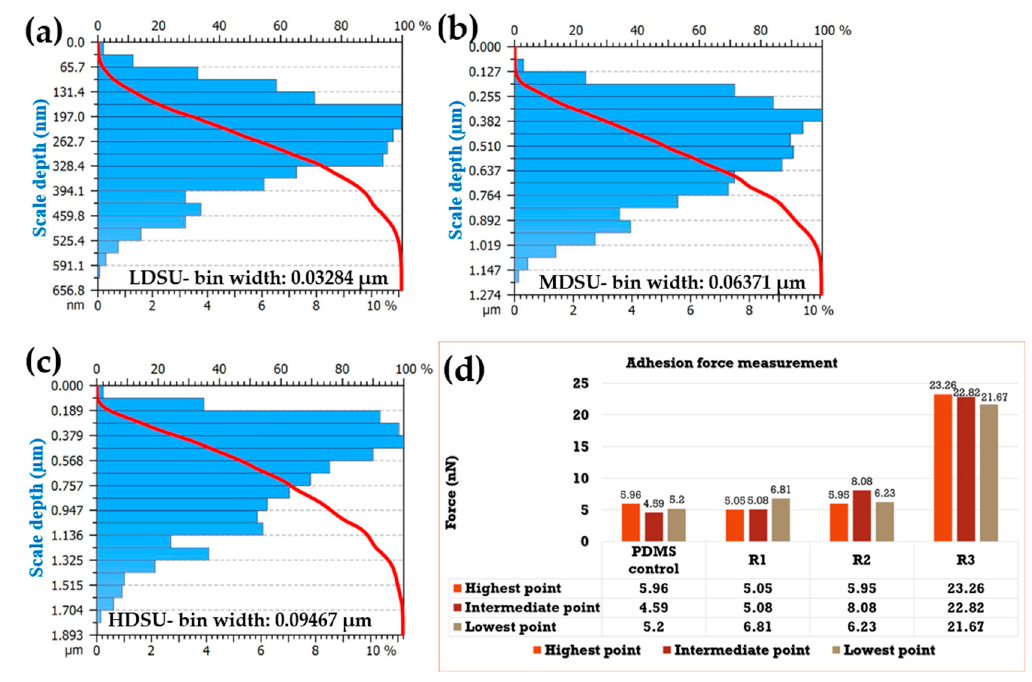
Figure 3. Distribution of PDMS depths: ( a ) LDSU; ( b ) MDSU and ( c ) HDSU. The obtained histograms show the depth values on the vertical left-side; each histogram contains a number of 20 bins, with the bin width of 0.03284 µ m (a-PDMS–LDSU), 0.06371 µ m (b-PDMS–MDSU) and 0.09467 µ m (c-PDMS–HDSU), respectively. The bin widths were assigned automatically by the software (APEX 3D BASIC software analyses V7, Digital Surf, Besançon, France, 2016, approved by ISO 25178). ( d ) Histogram representation showing the adhesion force values of the different PDMS replicates.